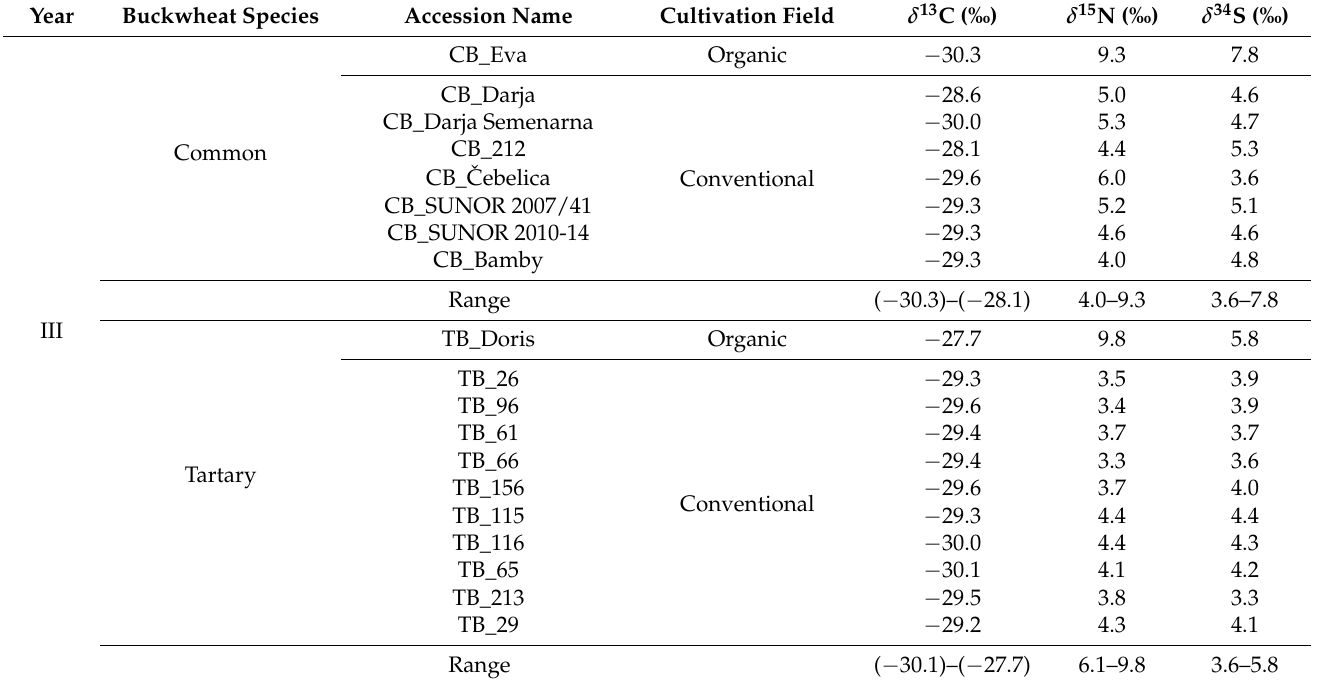
Table 2. The isotopic signature of whole grains of eight common and eleven Tartary buckwheat genetic resources produced conventionally and organically at Infrastructure Center Jablje in 2014.